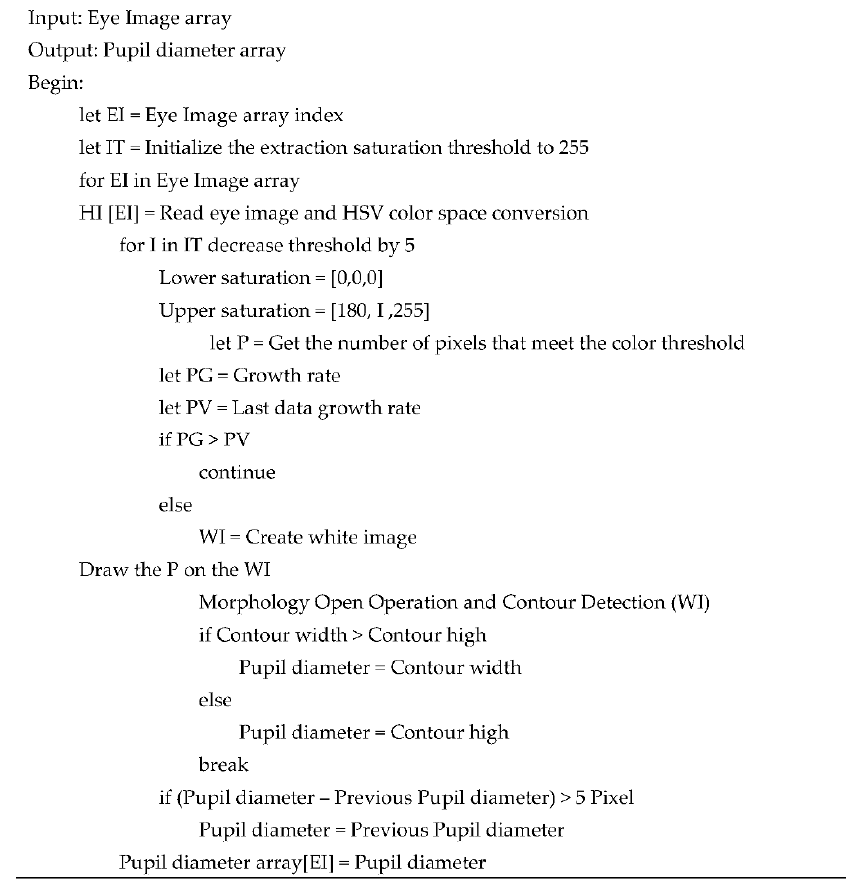
Figure 44. Pseudocode of the developed PRSSM algorithm.